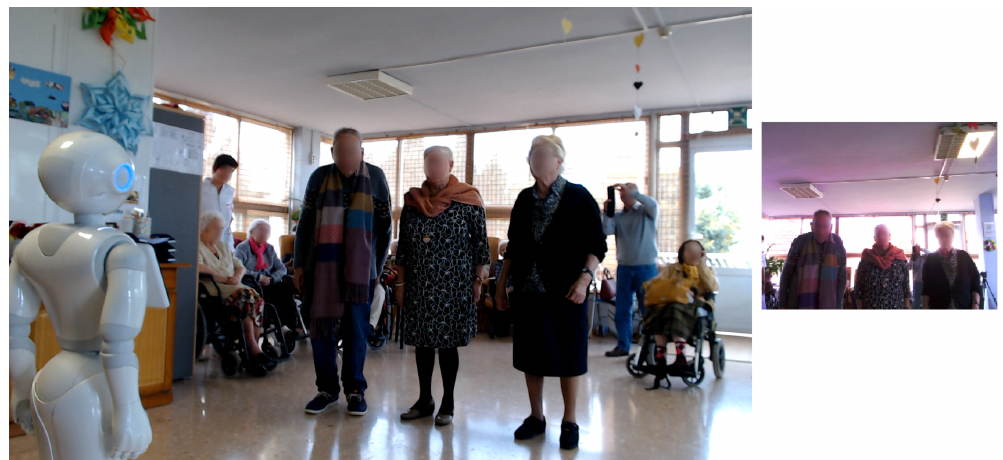
Figure 9. The left image shows the set-up of the pilot study where the robot is located in front of the users and there are some observers behind them; while the right image corresponds to the robot